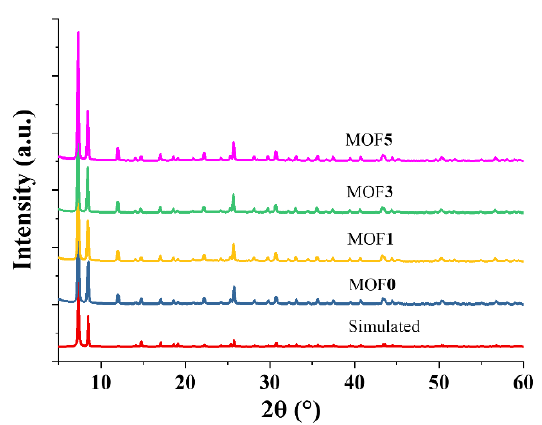
Figure 1. X-ray diffraction (XRD) patterns of the obtained metal organic framework (MOF) products.